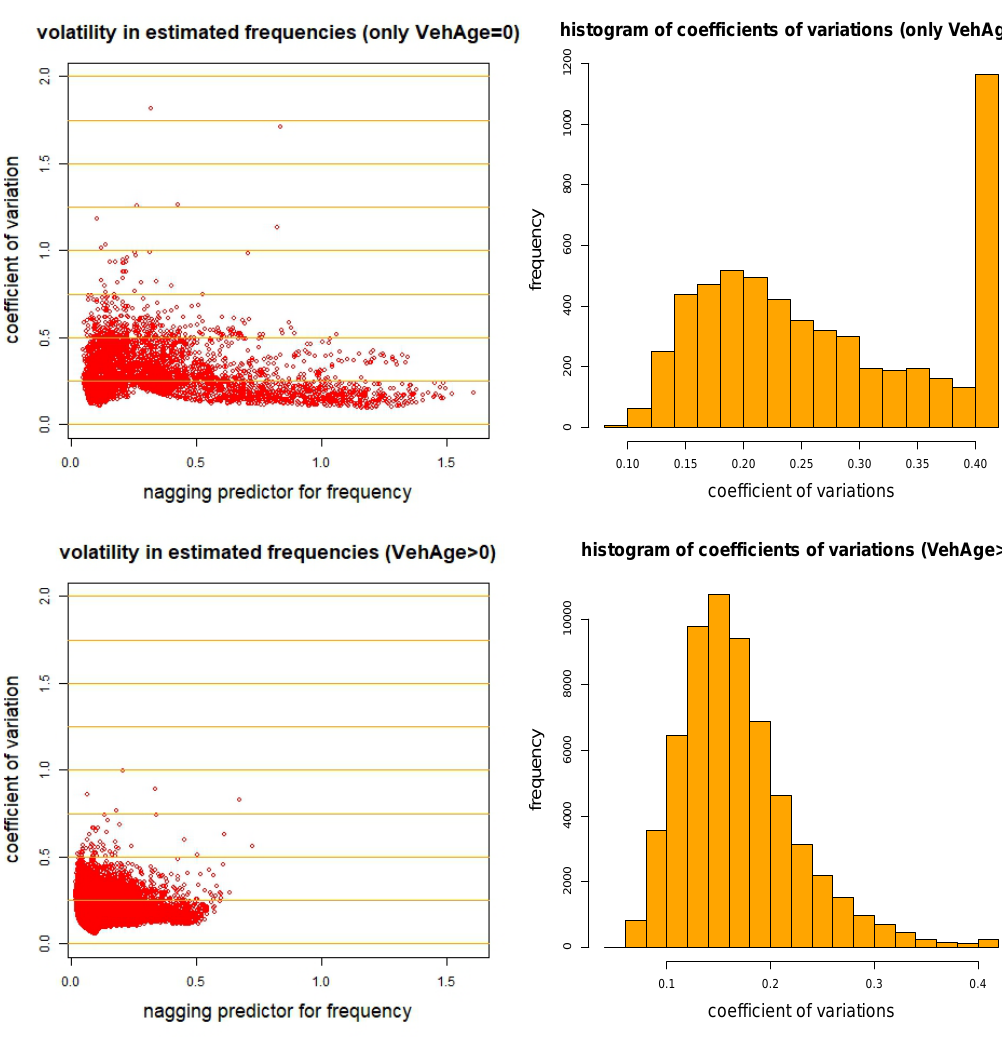
Figure 6. ( Top row ) Only vehicle age VehAge = 0, ( bottom row ) vehicle age VehAge > 0: coefficients of variation (cid:100) CoV t on individual policy predictions t = 1, . . . , m : (lhs) scatter plot against nagging ( M ) predictors ¯¯ µ , and (rhs) t